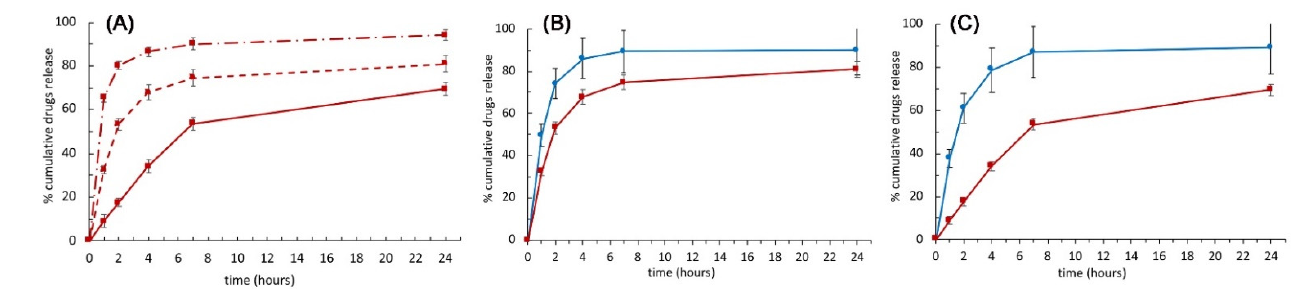
Figure 5. ( A ) Drugs cumulative releases. DK cumulative release profile over time from fibers (dash- dot line), mono-layer (dotted line), and double-layer composites (continuous line). ( B ) Comparison between CTC (blue) and DK (red) cumulative release profiles over time from mono-layer ( B ) and double-layer composite devices ( C ), respectively.